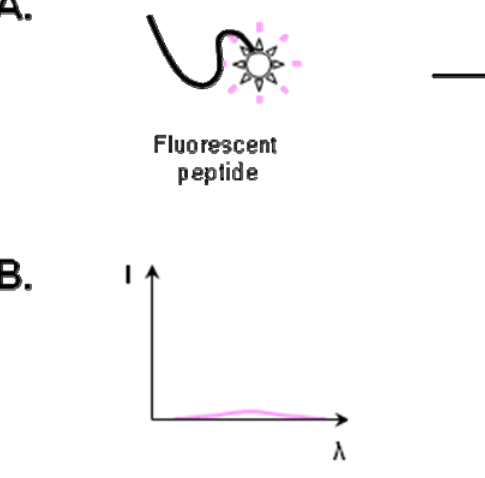
Figure 1. Principle of a fluorescent peptide biosensor. A) Schematic drawing showing the effect of analyte binding. The fluorophore attached close to the binding site responds to a microenvironmental change. B) Binding of analyte is detected by changes in the fluorescence emission spectrum. Adapted from [18], with permission from the American Chemical